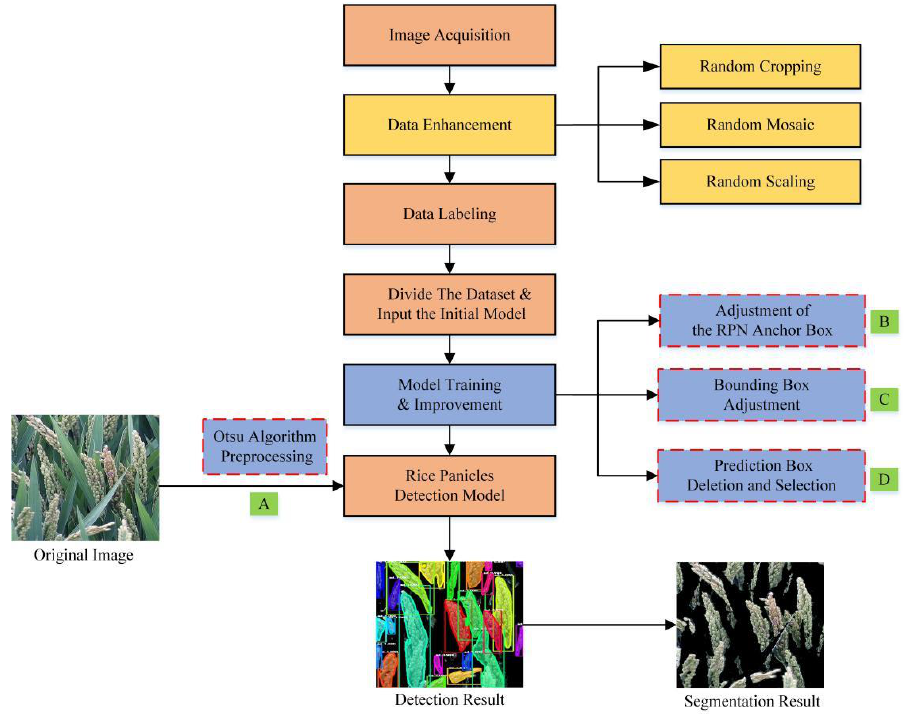
Figure 3. Panicle-Mask rice panicle detection and segmentation algorithm flowchart.